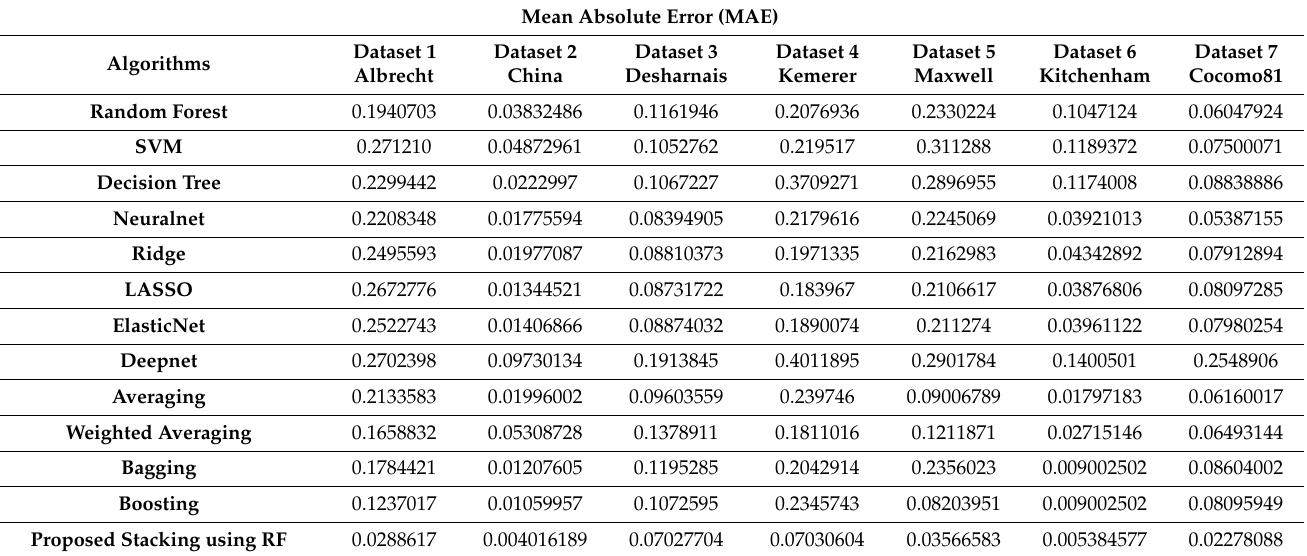
Table 4. Base learners and ensemble techniques vs. MAE of 7 datasets.